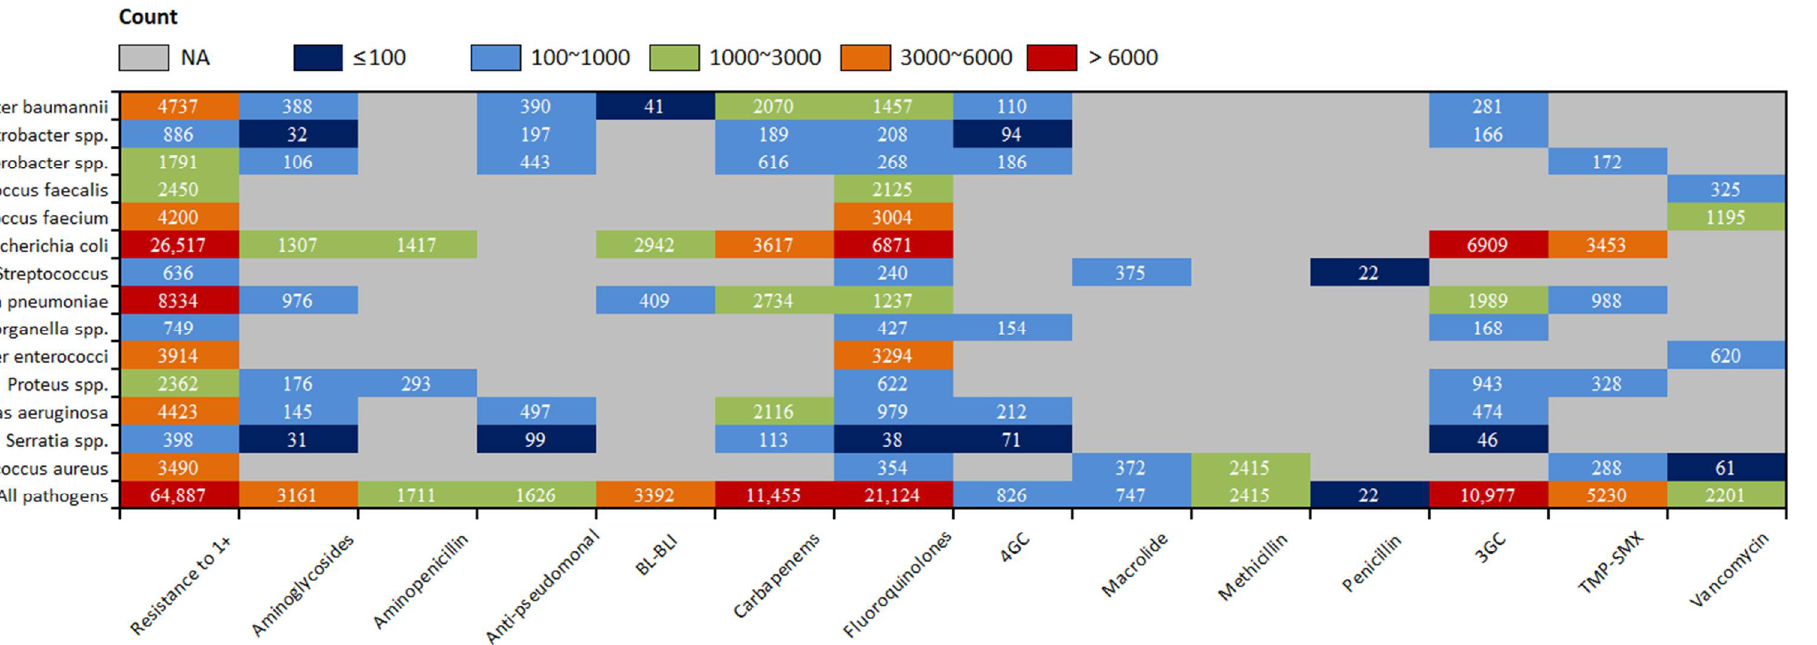
Figure 4. All-age count of deaths attributable to bacterial AMR globally among 13 antibiotic classes and 14 pathogens, 2019. The deaths associated with resistance are not shown due to the very high levels of correlation for resistance patterns between some drugs. 3GC = third-generation cephalosporins. 4GC = fourth-generation cephalosporins. Anti-pseudomonal = anti-pseudomonal penicillin or beta-lactamase inhibitors. BL-BLI = β-lactam or β-lactamase inhibitors. NA = not applicable. Resistance to 1+ = resistance to one or more drugs. TMP-SMX = trimethoprim/sulfamethoxazole. AMR = antimicrobial resistance. Error bars indicate 95% uncertainty intervals.